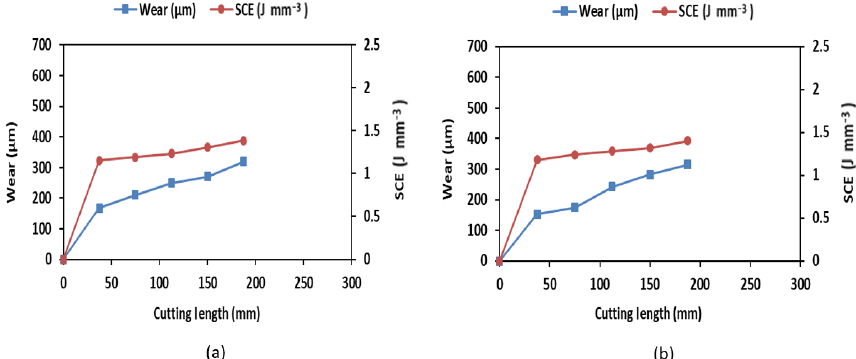
Figure 9. Variation in the SCE with the increase in the tool wear at different cutting lengths for (moderate wear region conditions); (a) Con-